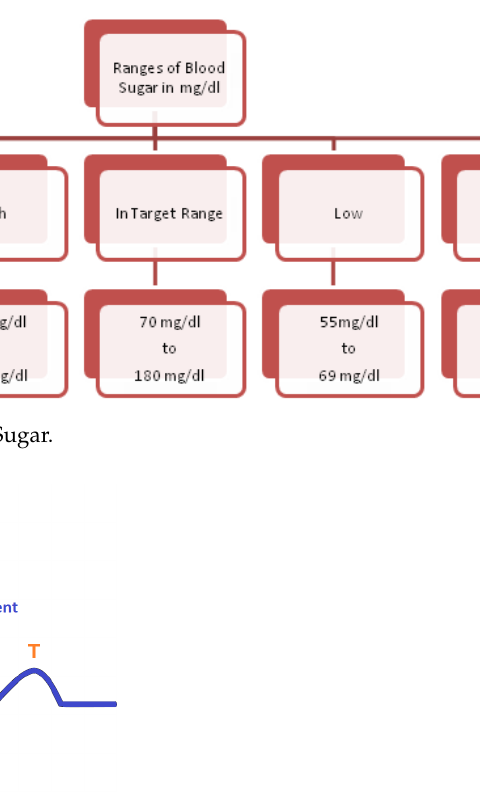
Figure 4. ST-segment in ECG (source: Wikipedia).